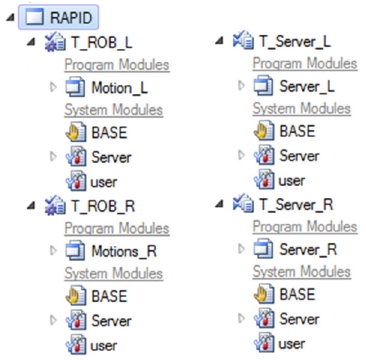
Figure 2. Illustration of modules for each arm of YuMi robot.